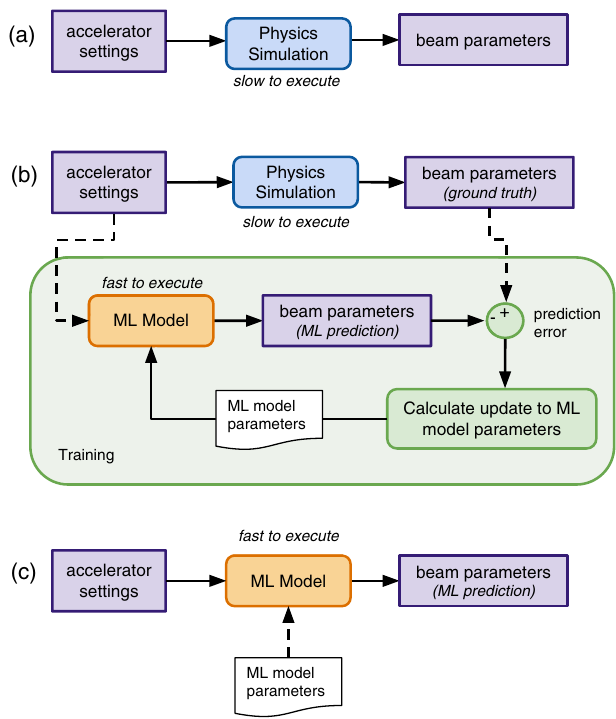
FIG. 1. Initially, we have a computationally expensive physics simulation (a). We then use the physics simulation to generate a sparse set of training data for the ML model that covers a wide range of input settings. The ML model parameters are then optimized until the predictions of the beam parameters match those from the physics simulation (b). The result is a fast- executing representation of the physics simulation that can be used for optimization and on-line modeling